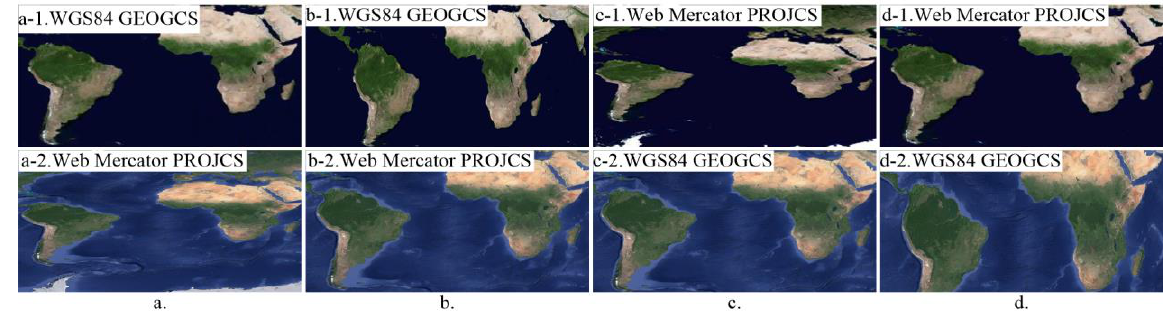
Table 3. Design under the different data sources and different spatial references